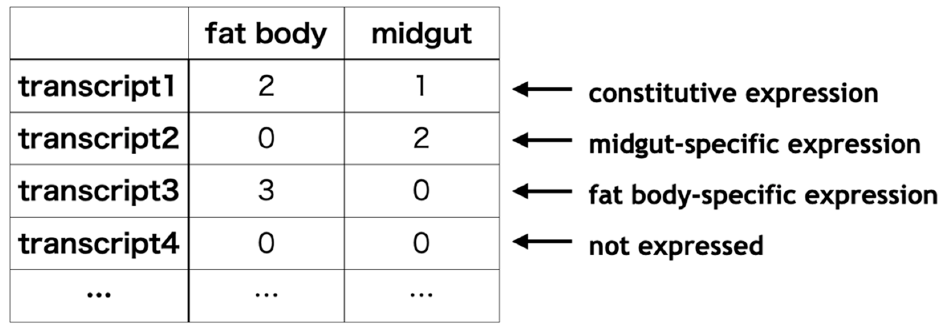
Figure 3. Annotation workflow for transcript description from expression information.